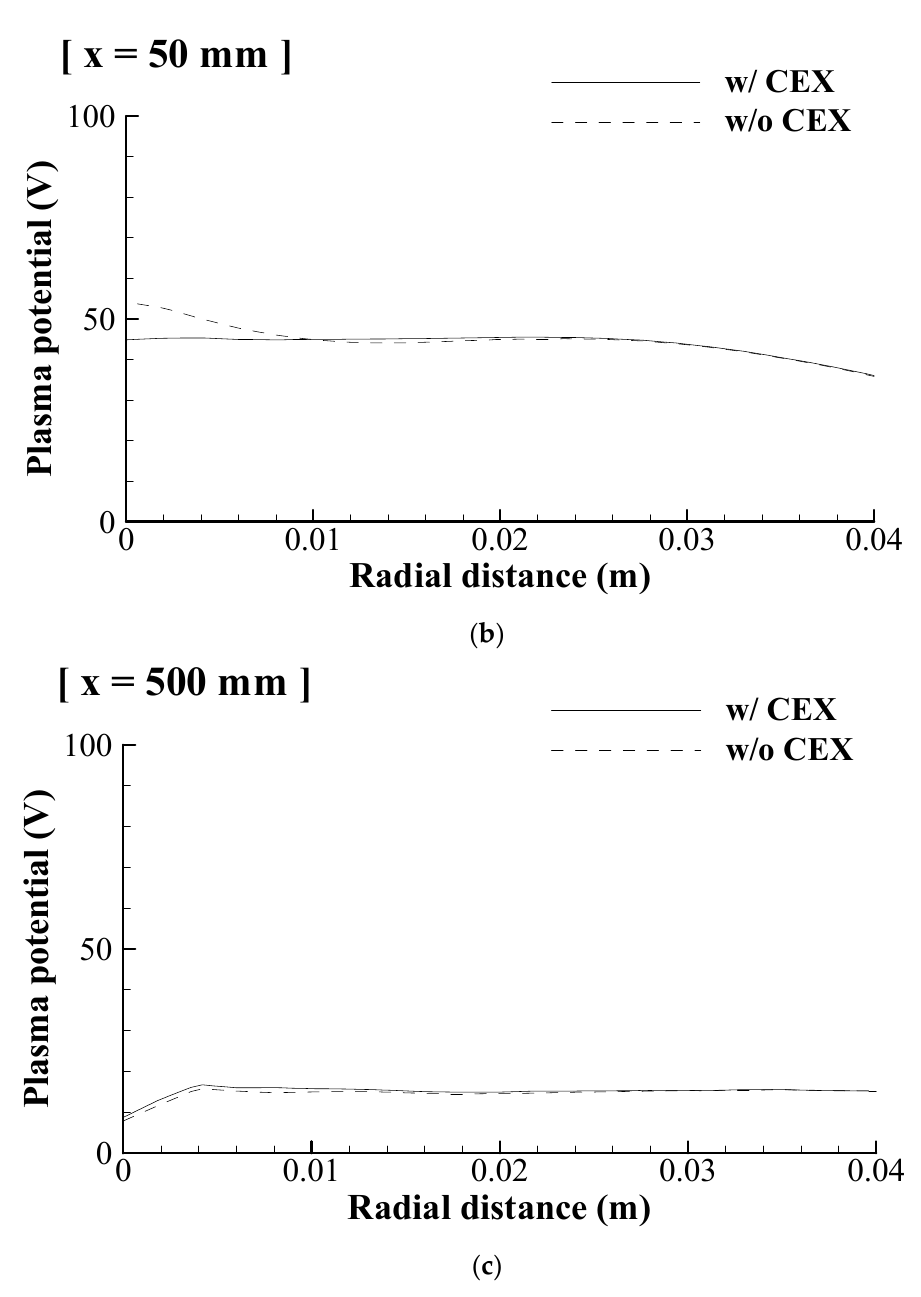
Figure 10. CEX effects on the radial profiles of the plasma potential: ( a ) x = 10 mm; ( b ) x = 50 mm; ( c ) x = 500 mm.